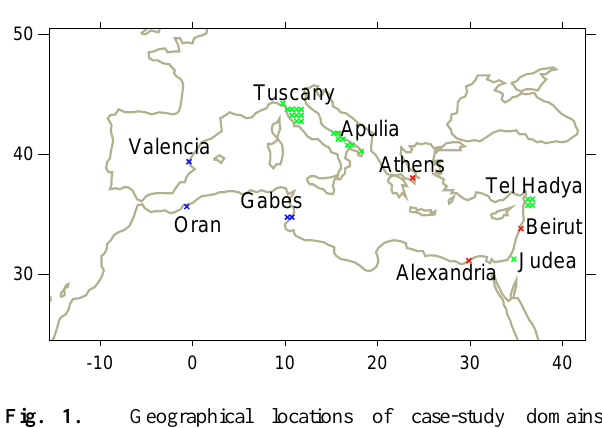
Fig. 1. Geographical locations of case-study domains. Red/Green/Blue: Urban/Rural/Coastal case-study domains (see Table